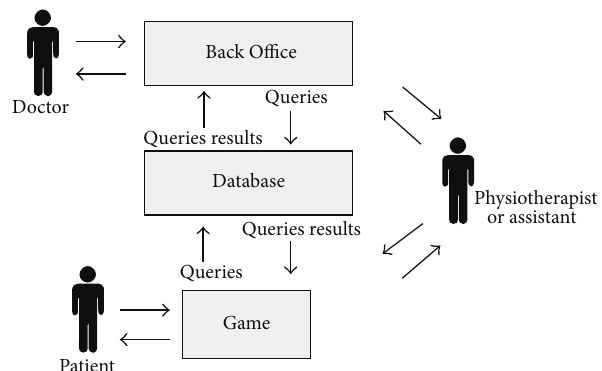
Figure 2: System behavior in a three-dimensional